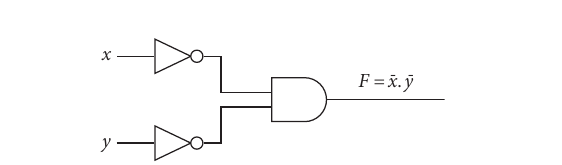
Figure 2: Implementation of Boolean function F � x.y with gates.